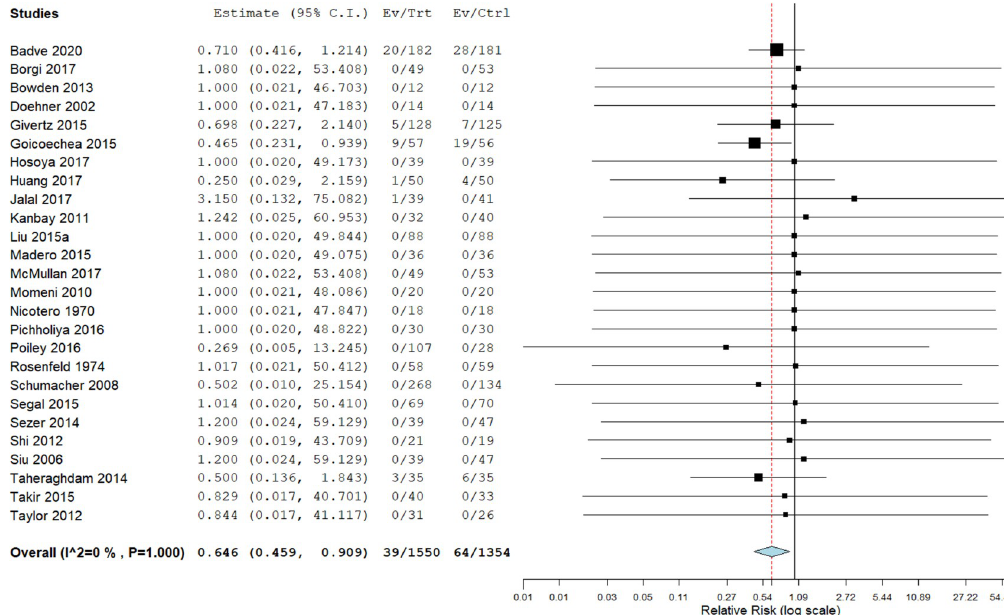
Fig 3. Forest plot of combined outcome (cardiovascular mortality, myocardial infarction and stroke). Overall effect of allopurinol on the combined outcome: p = 0.01.